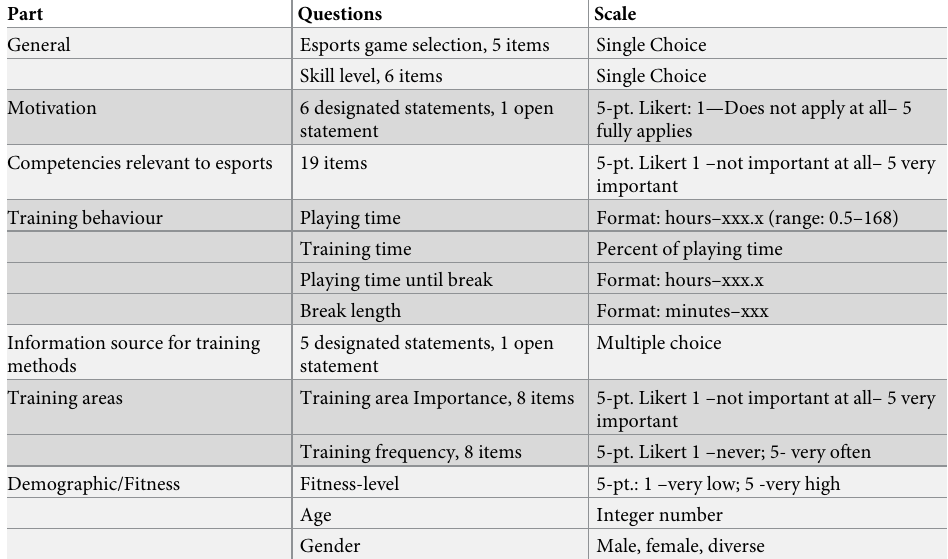
Table 9. Questions and scales applied in the survey.